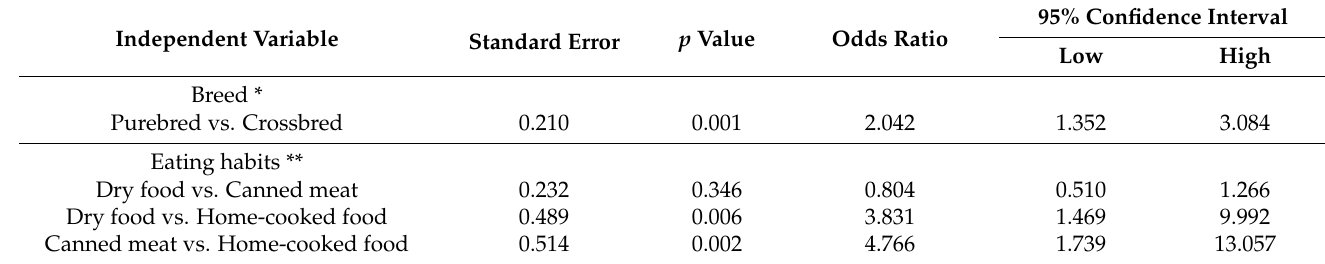
Table 3. Results of logistic regression